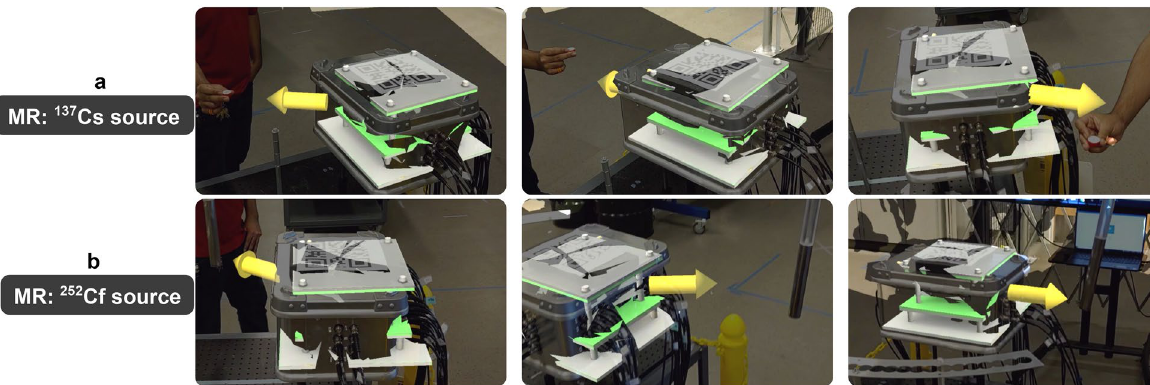
Figure 4. Examples of the mixed reality visuals as seen by the user wearing the HoloLens2 for the fast source direction estimate using a neural net. ( a ) A 100 µ Ci 137 Cs source is held in three different locations around the detector, the MR display shows a yellow arrow to represent the neural nets’ guess. ( b ) A 1 mCi 252 Cf source is held at different locations around the detector. The prediction and display of the source’s estimated location took less than 1 second in every